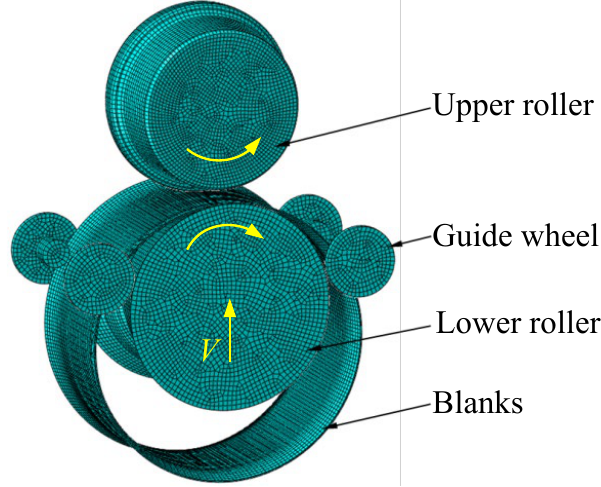
Figure 1. Roll-forming model.